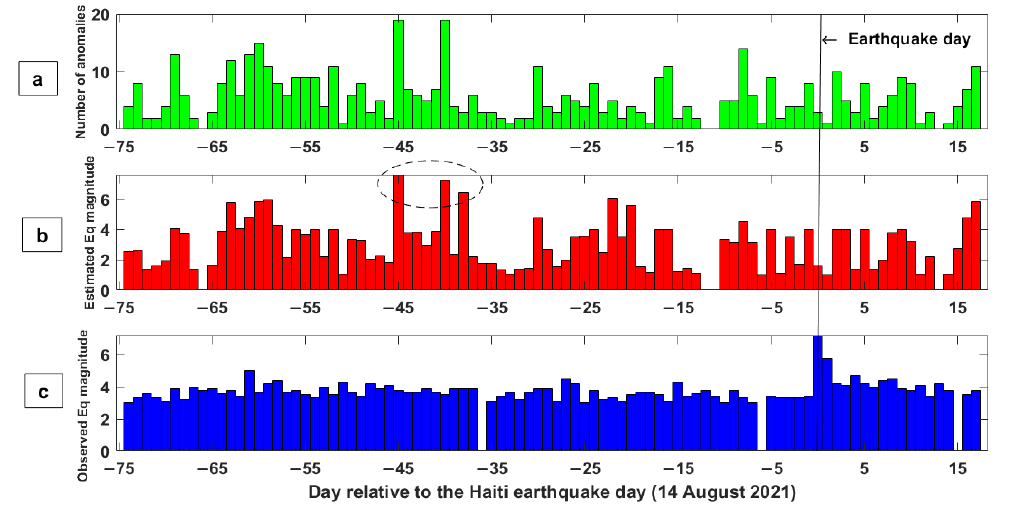
Figure 10. ( a ) Variation in the number of anomalies (green curve), ( b ) variation in the predicted earthquake magnitude (red curve), and ( c ) variation in the observed earthquake magnitude (blue curve) for the Haiti earthquake (14 August 2021) from 1 June to 31 August 2021. In both panels, the x -axis represents the day relative to the earthquake day, indicated as a vertical dotted line.